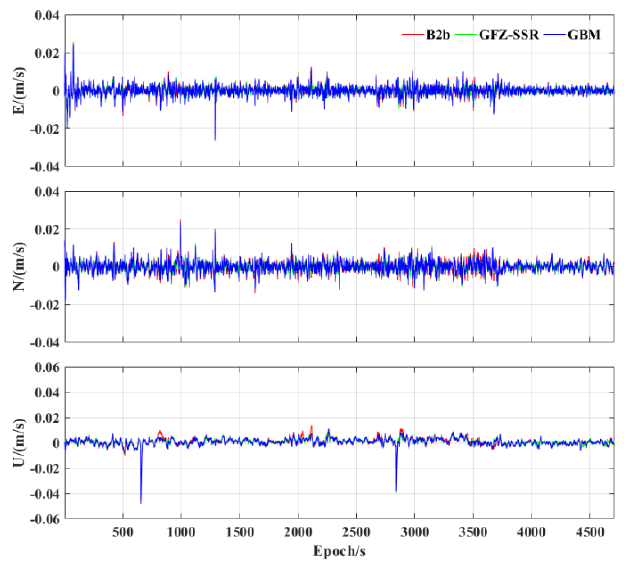
Figure 8. Velocity error of the three precise products using tactical IMU. Table 5. RMS statistics of velocity error for the three precise products using tactical IMU (unit: cm/s). Scheme